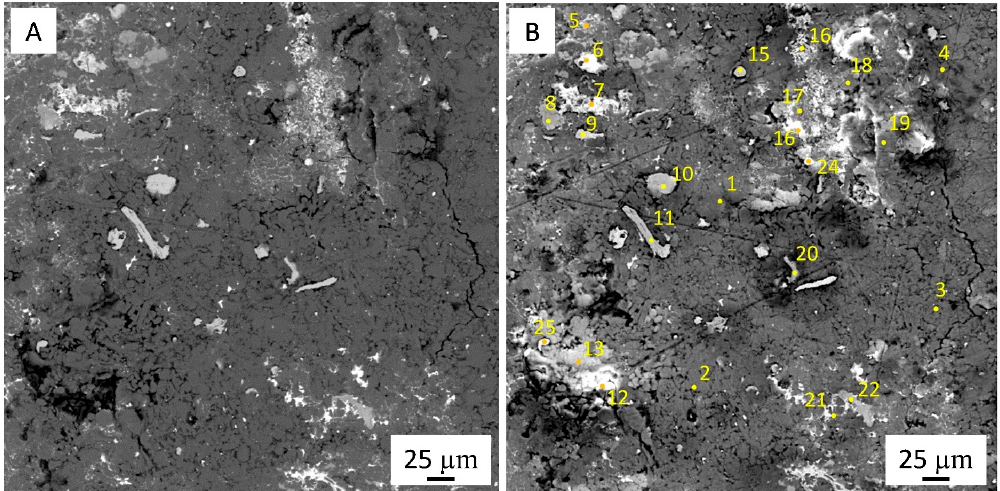
Figure 3. BSE mode ( A ) and SE mode ( B ) with EDS analysis points SEM images of the M2 alloy.